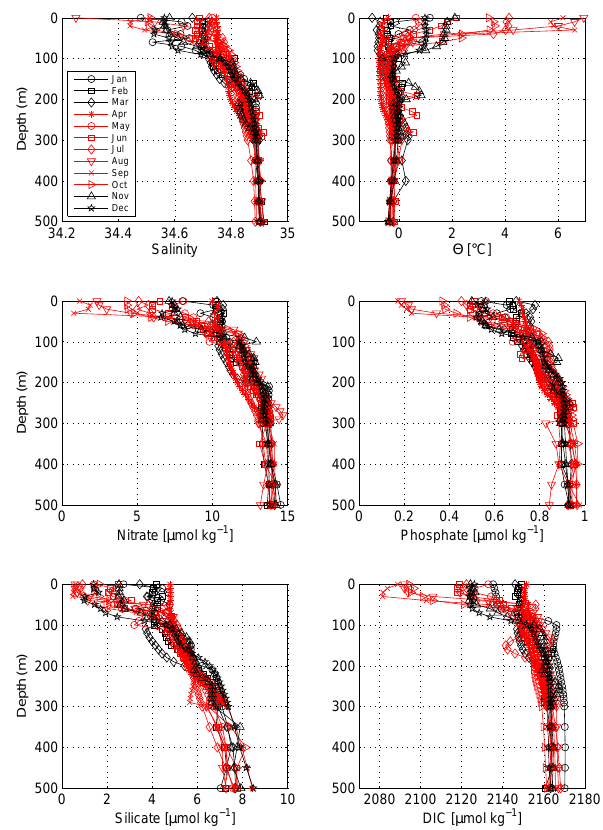
Figure 3. Mean monthly concentration profiles (upper 500m) in the Iceland Sea, of salinity (upper left), potential temperature (upper right), nitrate (middle left), phosphate (middle right), silicate (lower left), and DIC (lower right). The black profiles indicate months with an increase in MLD (compared to previous month) and the red pro- files depict months with a decreased or very shallow ( < 40m) MLD (see Fig.